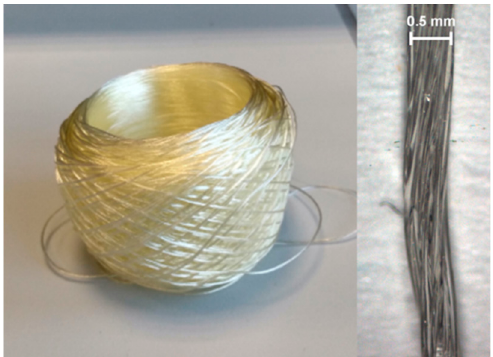
Figure 8. Images of a yarn made from polyvinyl alcohol and glycerol using the Spinning Rosi (from right to left), a spooled roll of the yarn material, and a light microscopy image of the degraded fiber materials.